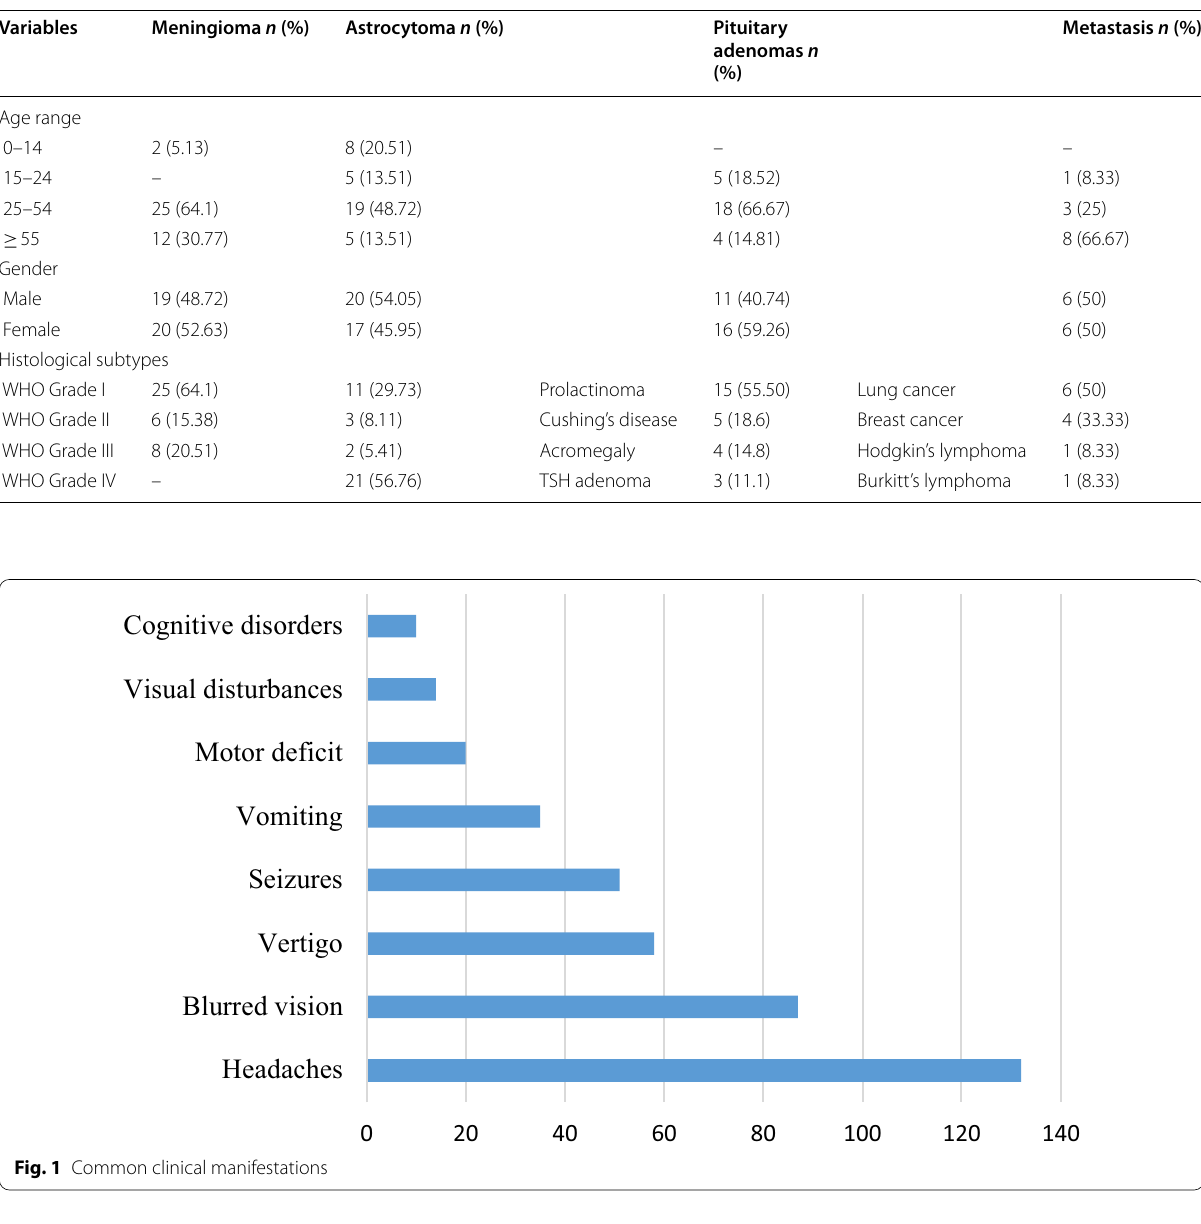
Table 3 characteristics of the commonest